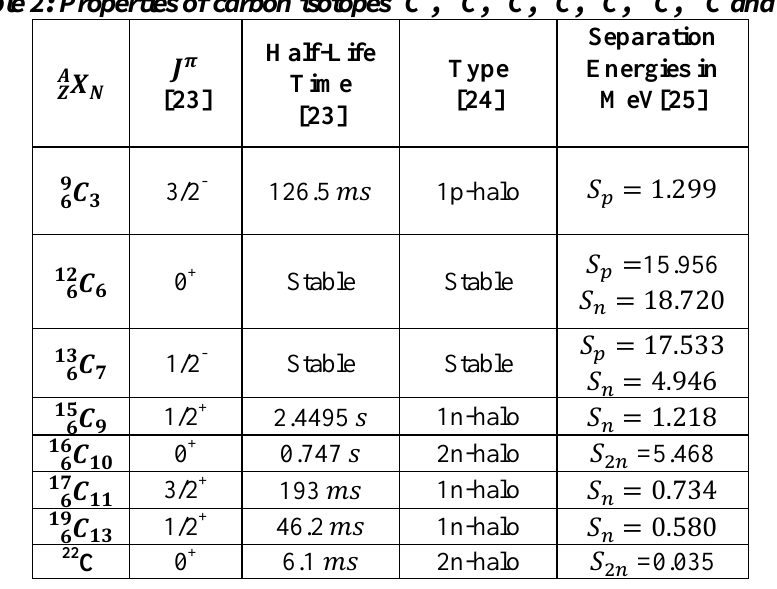
for Carbon isotopes 9 C, 15 C, p,n